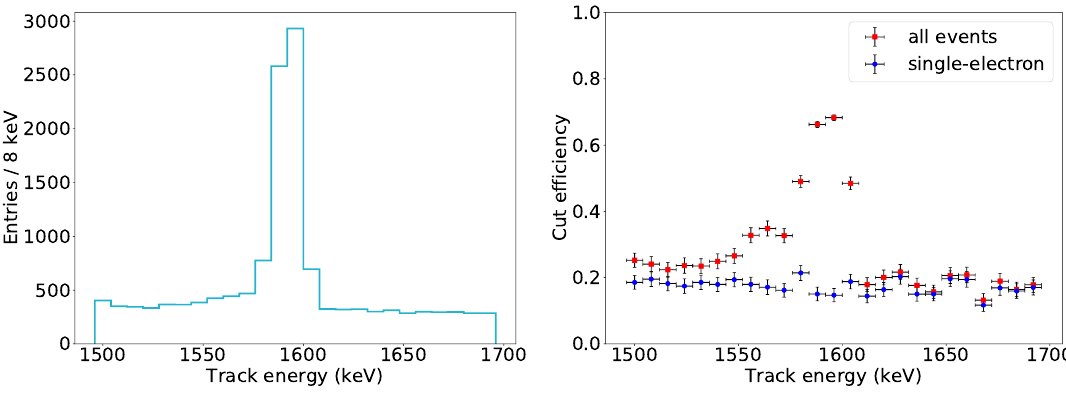
Figure 7 . Blob cut e(cid:14)ciency for Monte Carlo, using the full event sample and a sample of single- electron events. The histogram on the left side represents the full sample of track energies and the plot on the right side shows the fraction of the total number of events passing the cuts for each one of the two